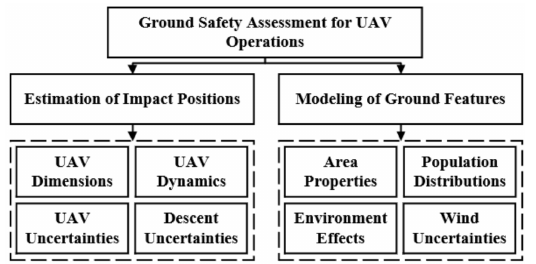
Figure 1. Problem